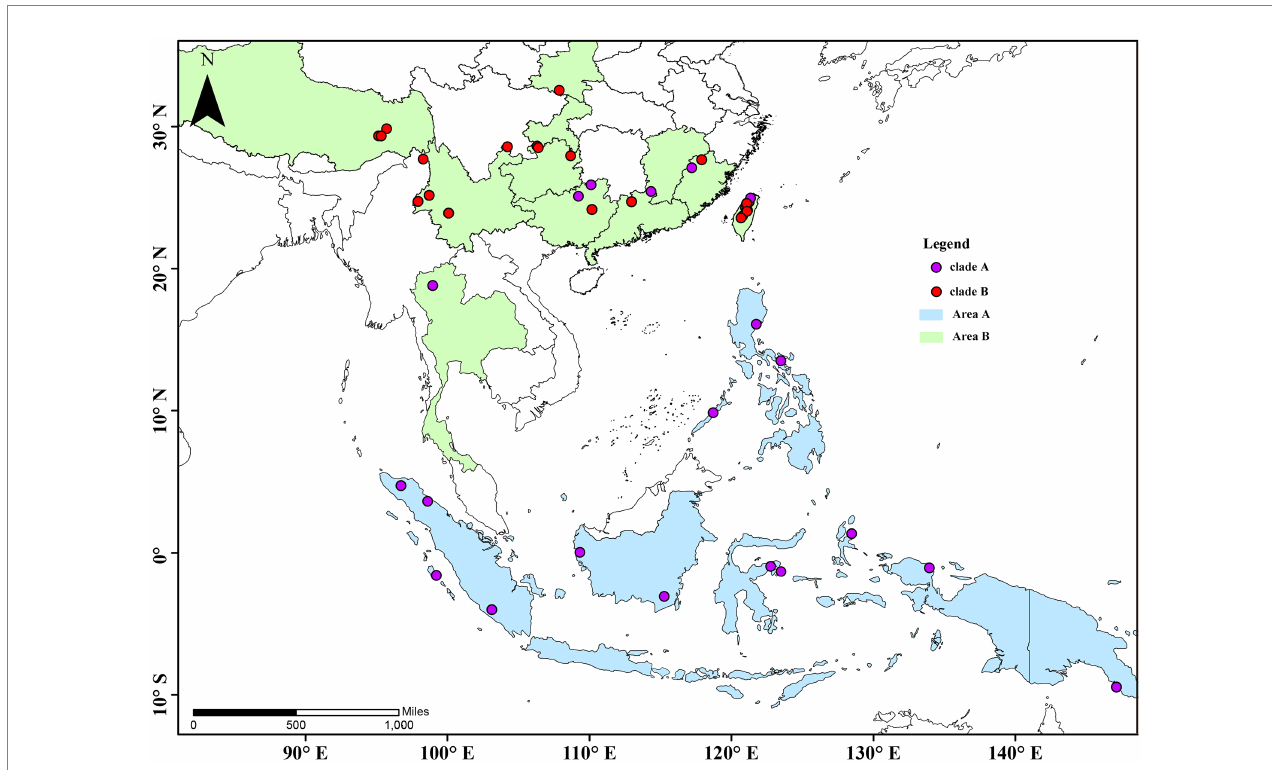
FIGURE 1 Collection sites and species distribution map of Cyclommatus stag beetles. The map is drew using ARCGIS v10.2 (http://www.esri.com/sofware/arcgis) based on the geospatial data from the National Geomatics Center of China.